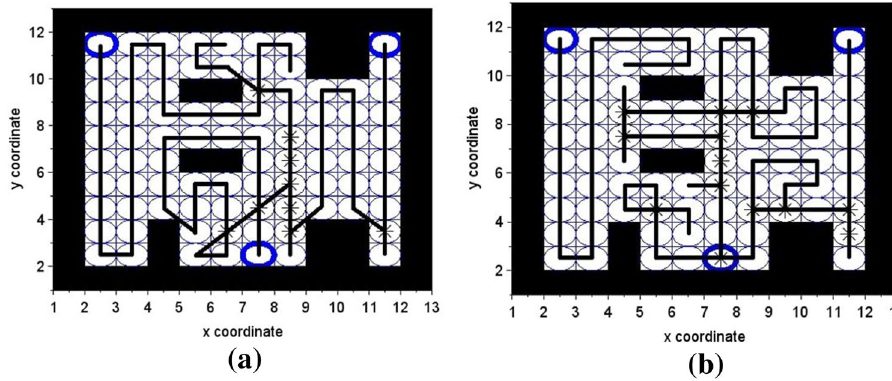
Fig. 15 Comparison with Sun’s algorithm with three robots: